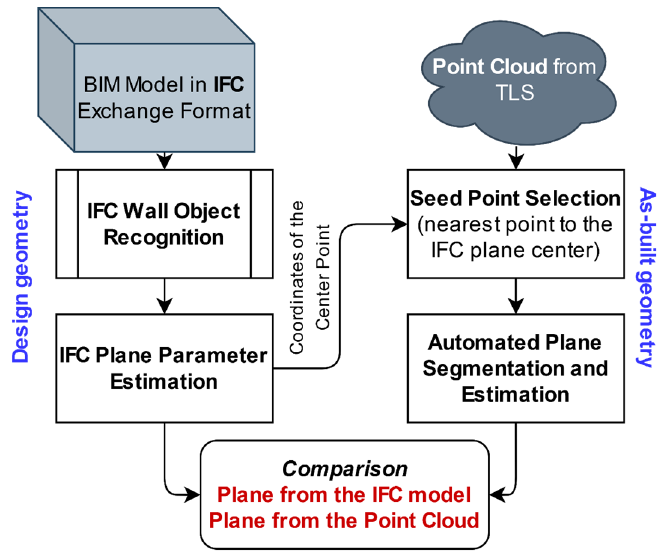
Figure 1. Flow chart of wall structure verification.